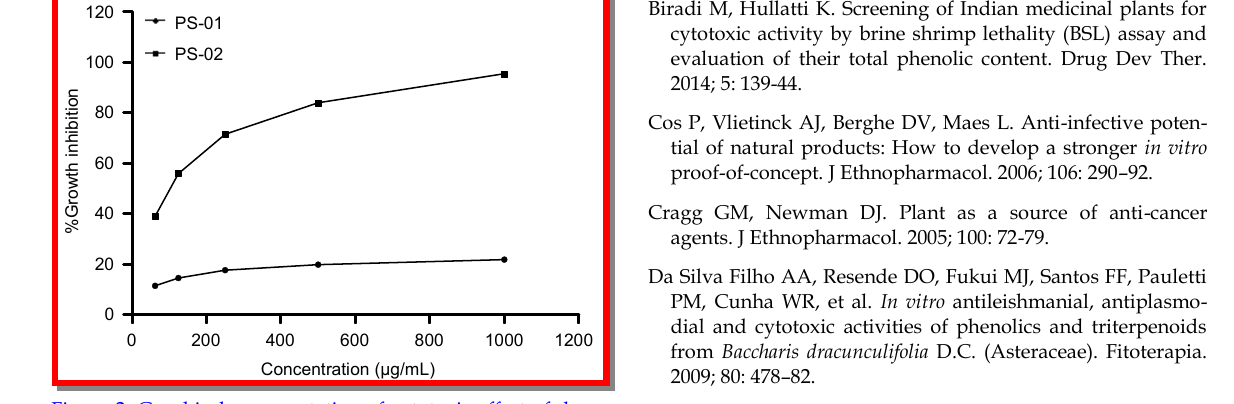
Figure 2: Graphical representation of cytotoxic effect of drugs on HT-29 cell